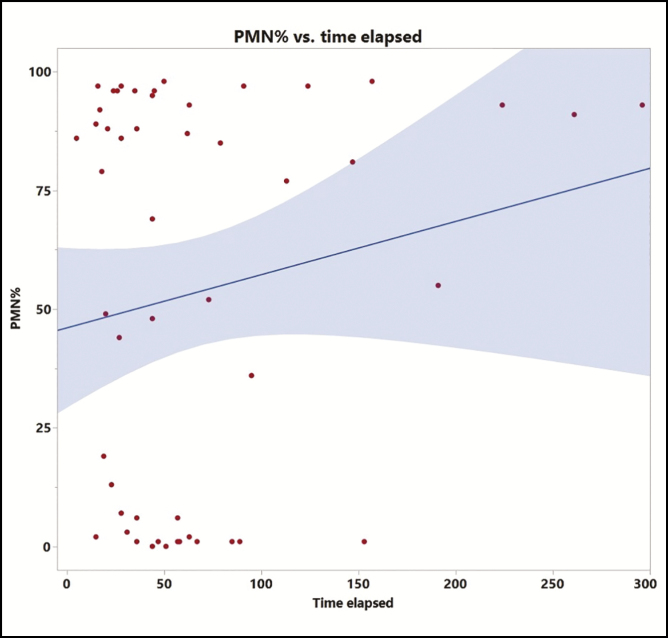
Bivariate analysis of time elapsed (in days) between initial implant placement and PMN% at the time of fluid sampling. Line of best fit shown with correlation coefficient, r2 = 0.029, indicating a limited relationship between these variables.